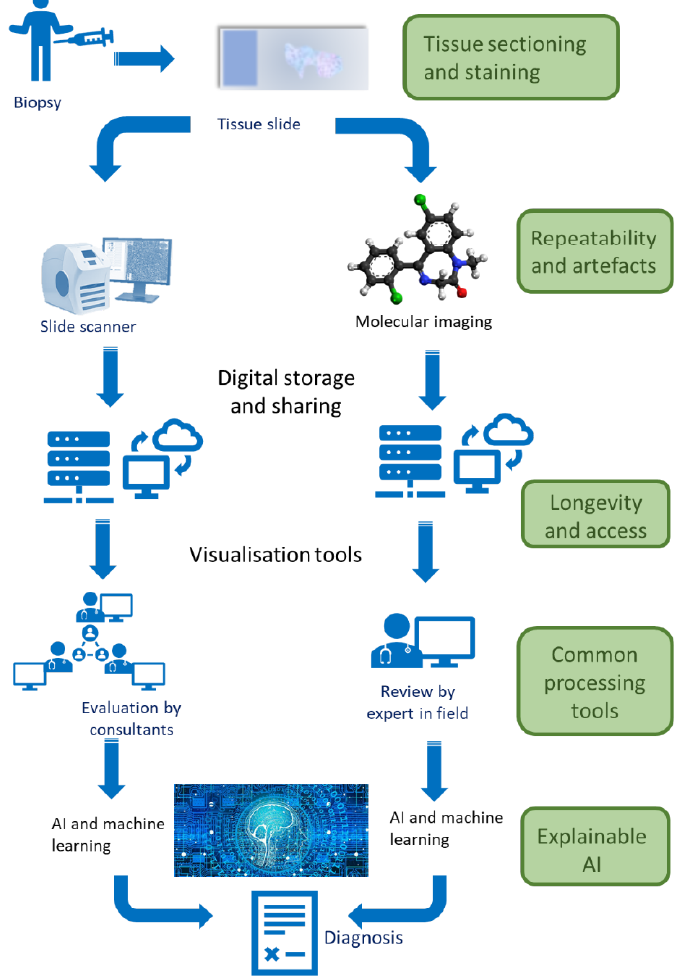
Figure 1. Example of a digital pathology workflow (left), and its equivalent molecular pathology workflow (right). Many of the steps involved have similar challenges, as highlighted in the green